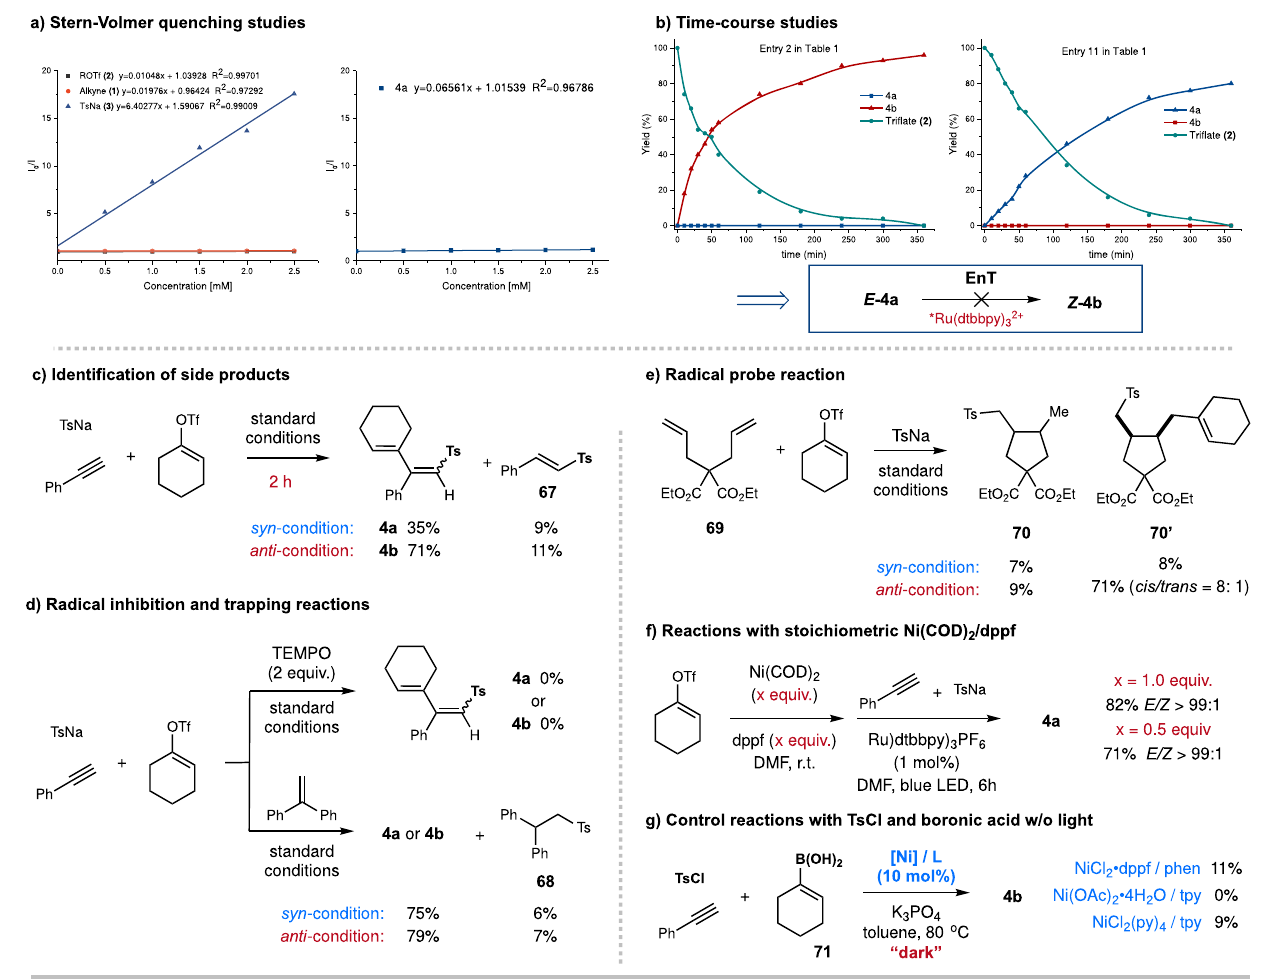
Fig. 4 | Mechanistic studies. a Stern-Volmer quenching studies; b Time-course studies; c Identi fi cation of side products; d Radical inhibition and trapping reactions; e Radical probe reaction; f Reaction with stoichiometric Ni(COD) 2 /dppf; g Control reactions with TsCl and boronic acid w/o light. EnT = Energy